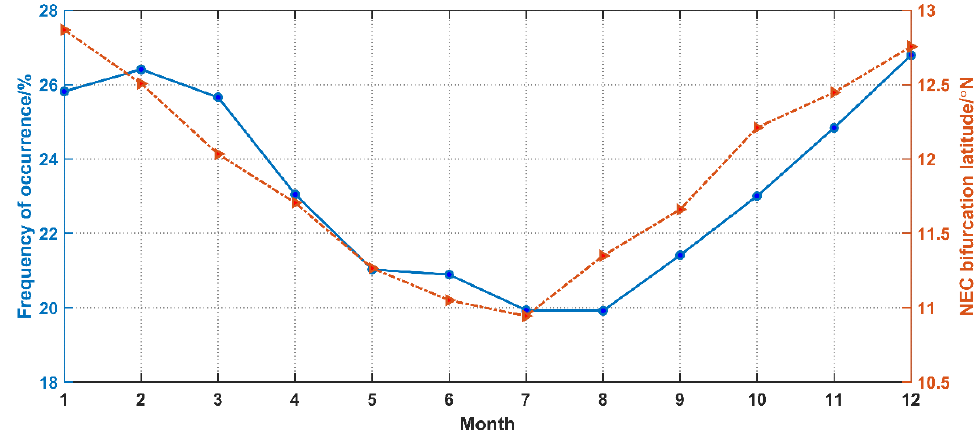
Figure 10. Frequency of H-Smax occurrence (blue line) and NEC bifurcation latitude (red line) as a function of calendar month.